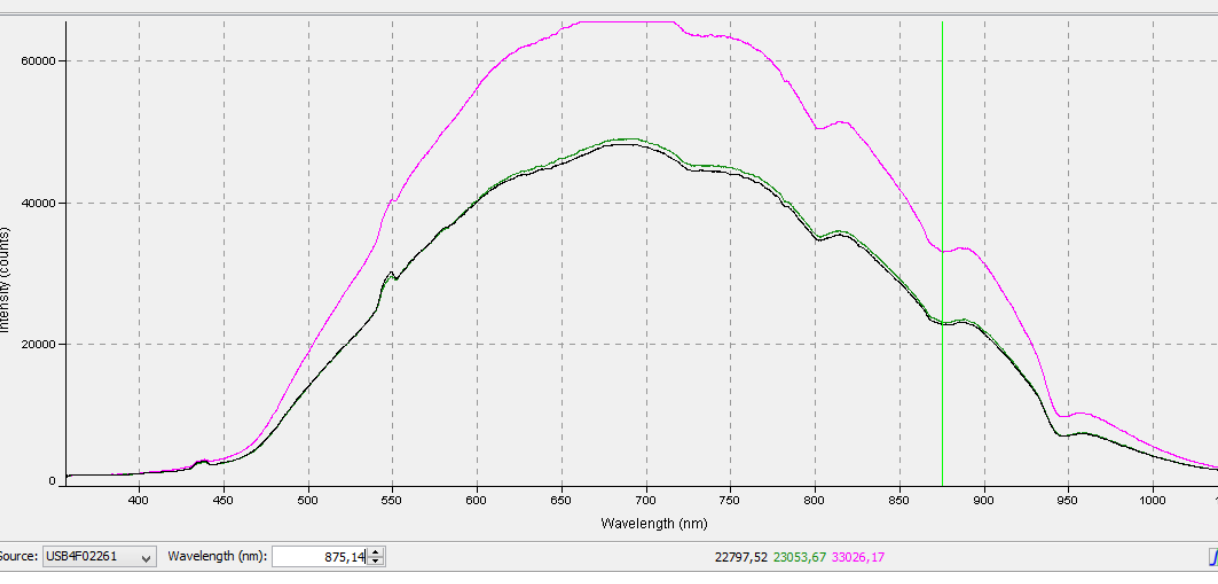
Fig. 4. The measured liquid phantom spectra